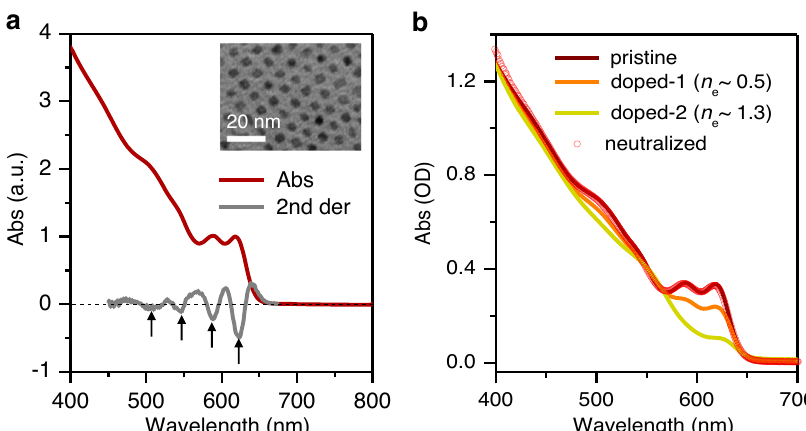
Fig. 2 Optical properties of QDs. a Absorption spectrum of 5.5-nm CdSe QDs (red) and its second derivative spectrum (gray). Four lowest energy transitions are indicated. Inset is a typical transmission electron microscope image of the QDs. b Absorption spectra of the pristine sample (wine), n - doped-1 (orange), n -doped-2 (yellow) and re-neutralized sample (red circles). The average numbers of doped conduction band electrons are ~0.5 and 1.3, respectively, for n -doped-1and n